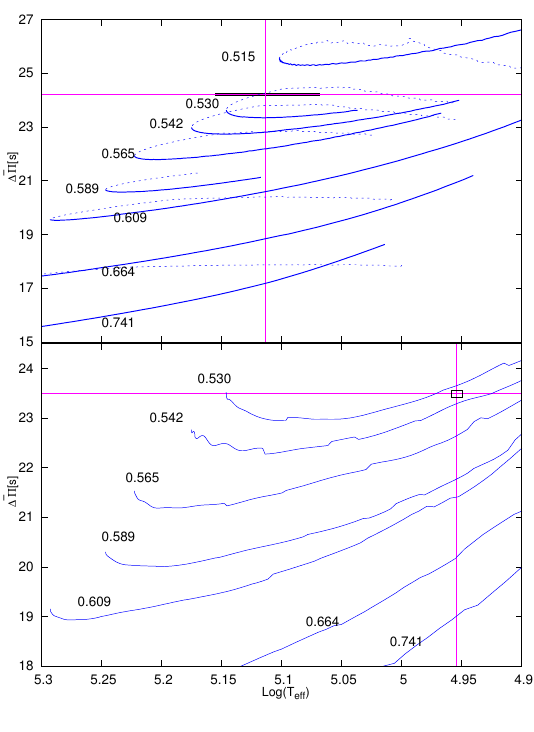
Figure 1. Average of the computed (cid:3) = 1 period spacings for VV47 (upper panel) and J0349 (lower panel) corresponding to our PG1159 evolutionary sequences in terms of log( T e ff ). Dashed (solid) lines correspond to evolutionary stages before (after) the “evolutionary knee”. Also shown are the observed period spacings and the T e ff , along with their